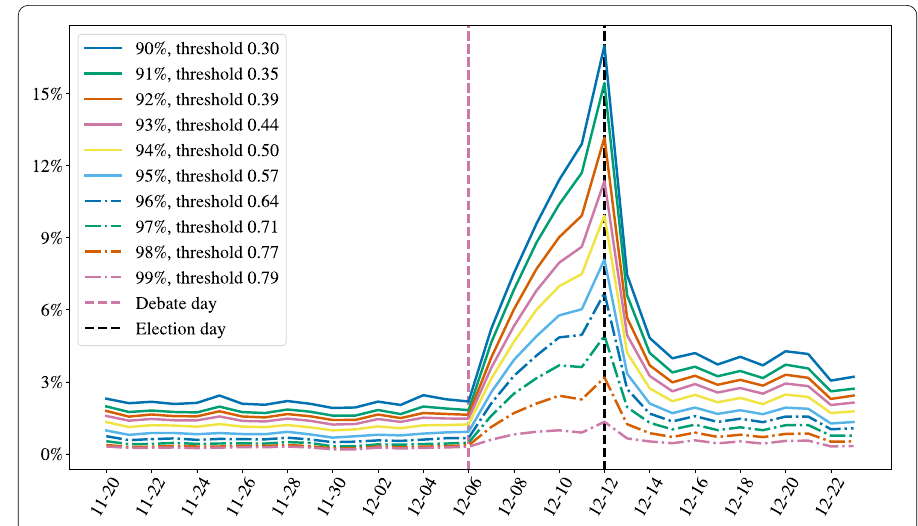
Figure 10 Percentage of bots per day obtained by setting different thresholds. Each threshold is chosen by considering as genuine a certain percentage of users over the entire period, as written on the legend. For instance, 90% of users are considered genuine (and the rest are bots) if the threshold is set at 0.3. The relative increase in bots’ presence appears independently of the chosen